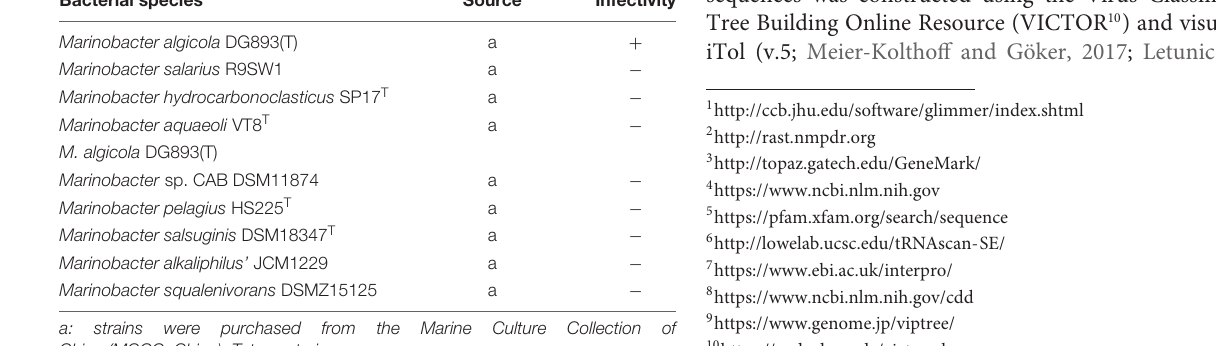
TABLE 1 | Bacterial strains used in this study to determine phage host range. Bacterial